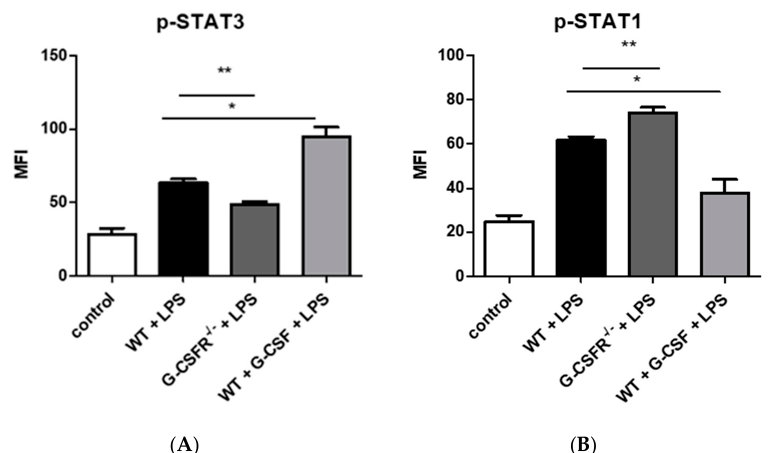
Figure 3. Stat signaling differs between untreated control and LPS-activated WT, G-CSFR − / − , and WT + G-CSF BMM as shown by ( A ) p-STAT3 ( B ) and p-STAT1 mean fluorescence intensity (MFI) by cell signaling bead array. n = 8; * p and ** p ≤ 0.05.